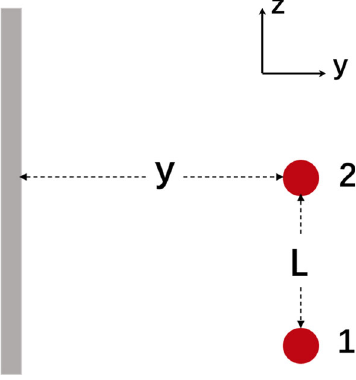
Fig. 3 Two independent gravitationally polarizable subsystems are placed along the z direction with a separation L , which are at a dis- tance y from a Dirichlet boundary in the xoz plane